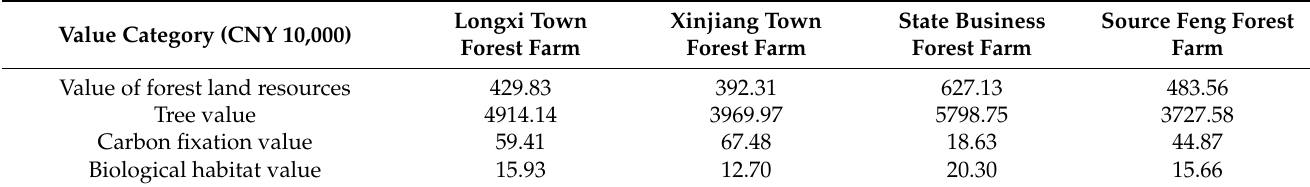
Table 7. Results of comprehensive economic value evaluation of forest